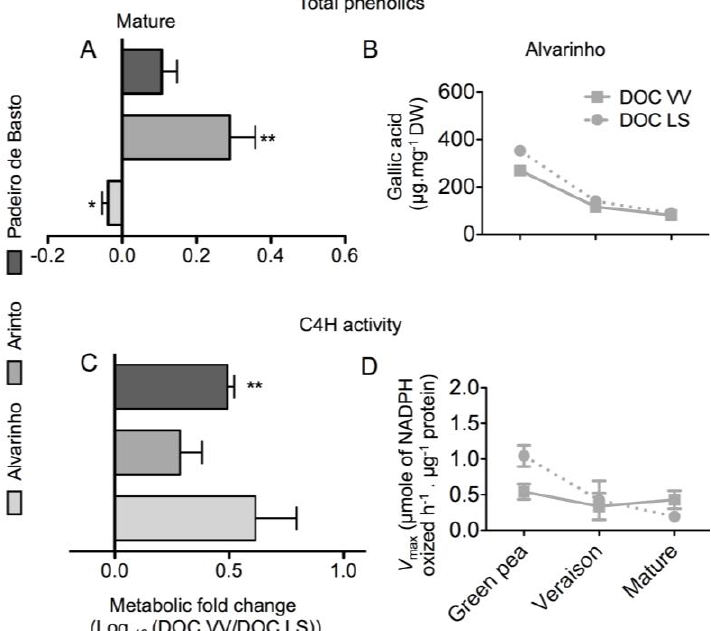
Figure 7. Fold difference of total phenolics and cinnamate 4-hydroxylase (C4H)-specific activity in mature grapes from Alvarinho, Arinto and Padeiro de Basto cultivated in the DOC VV and DOC LS region ( A , C ); Total phenolics and 4-hydroxylase (C4H)-specific activity during grape berry development in the Alvarinho variety ( B , D ). Values are the mean ± SE ( n = 3); asterisks denote the significance levels comparing DOC VV to DOC LS: * p ≤ 0.05; ** p ≤